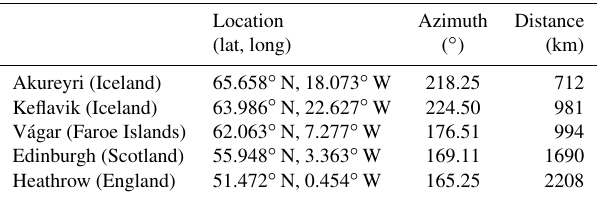
Table 2. Airport locations, azimuth, and distance to JM. Locations are expressed in lat–long coordinates. Azimuth and distance corre- spond to the azimuth in degrees and the distance between JM and the different